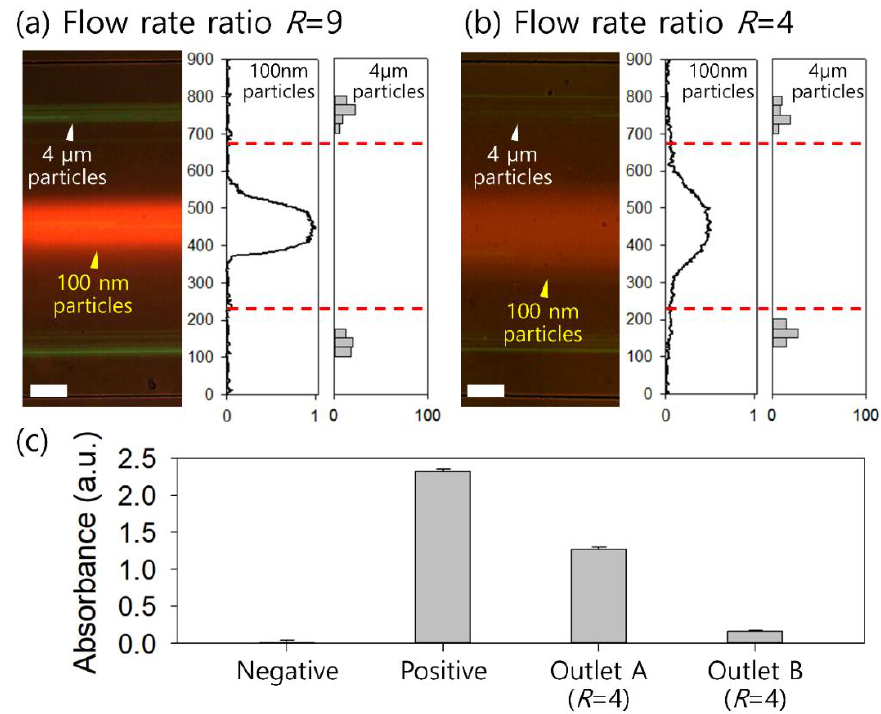
Figure 4. Effect of the sample-to-sheath flow rate ratio ( R ) of ( a ) 9 and ( b ) 4 on the medium exchange of 4 μ m particles from a 0.1% HA solution to deionized water (DW) in the co-flow device with AR = 2. The total flow rates were 100 µ L/min. ( c ) Absorbances measured by the UV-VIS spectrophotometer at 254 nm wavelength using the negative sample (inlet A), the positive sample (inlet B), and collected samples at the outlets with a flow rate ratio of 4.